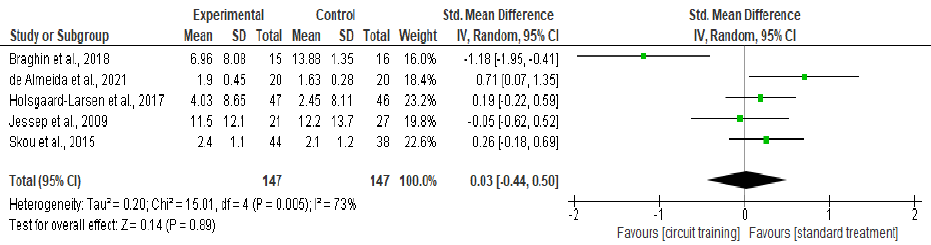
(Figure 6, Table 2) between the CT group and the standard treatment group.